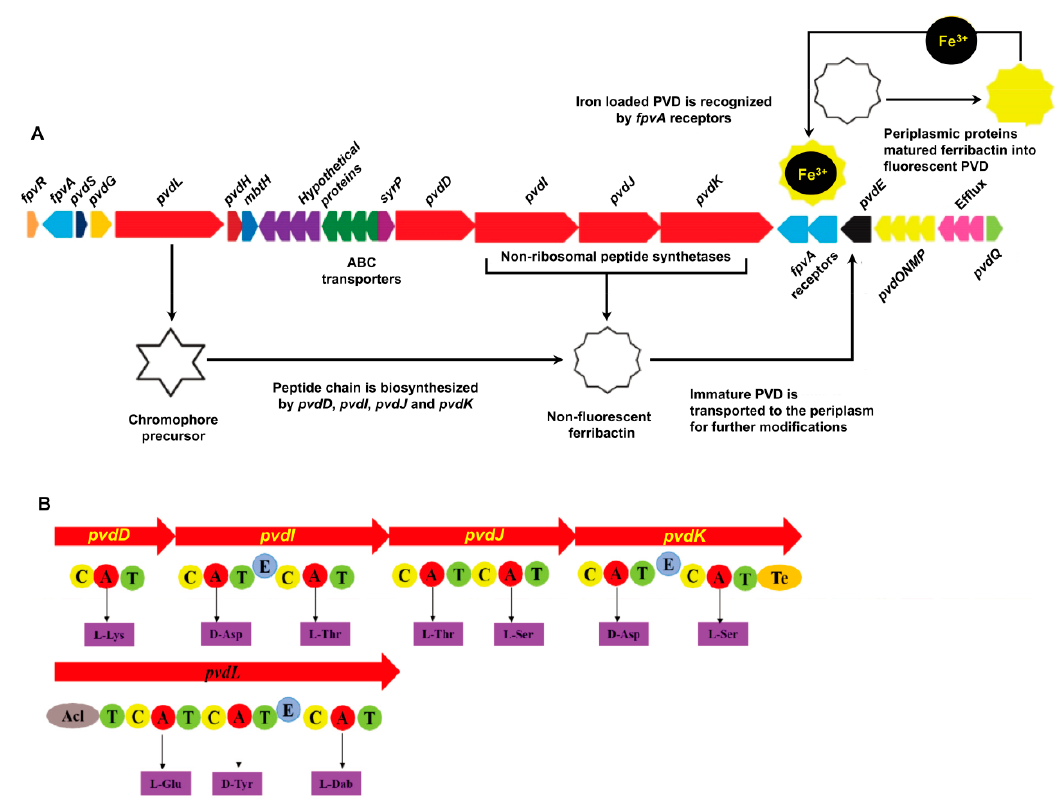
Figure 1. Genes involved in the biosynthesis of PVD in P. syringae MB03. ( A ) PVD genetic locus in the P. syringae MB03 genome: The red-colored genes encode non-ribosomal peptide synthetase (NRPS) enzymes ( pvdL / D / I / J / K ), which are involved in the biosynthesis of PVD. The dark blue colored-gene ( pvdS ) encodes an (extracytoplasmic function) ECF σ factor involved in the regulation of PVD biosynthetic and receptor genes, while the orange-colored gene ( fpvR ) encodes the anti- σ factor. Triplicate fpvA receptor genes are colored light blue; they are involved in the import of iron-loaded PVD into the cell. The immature PVD is transported into periplasm via the pvdE ABC (ATP-binding cassette) transporter, where a number of periplasmic proteins modify it to produce the mature PVD. SyrP , indicated in the purple color is an aspartate hydroxylase predicted to be involved in the β -hydroxylation of aspartate residues present in the PVD peptide chain. ( B ) Non-ribosomal peptide synthetases encoded in the MB03 PVD genetic cluster: Each enzyme consists of di ff erent domains, such as condensation (C), adenylation (A), thiolation (T), epimerization (E), and thioesterase domains (Te). Ten